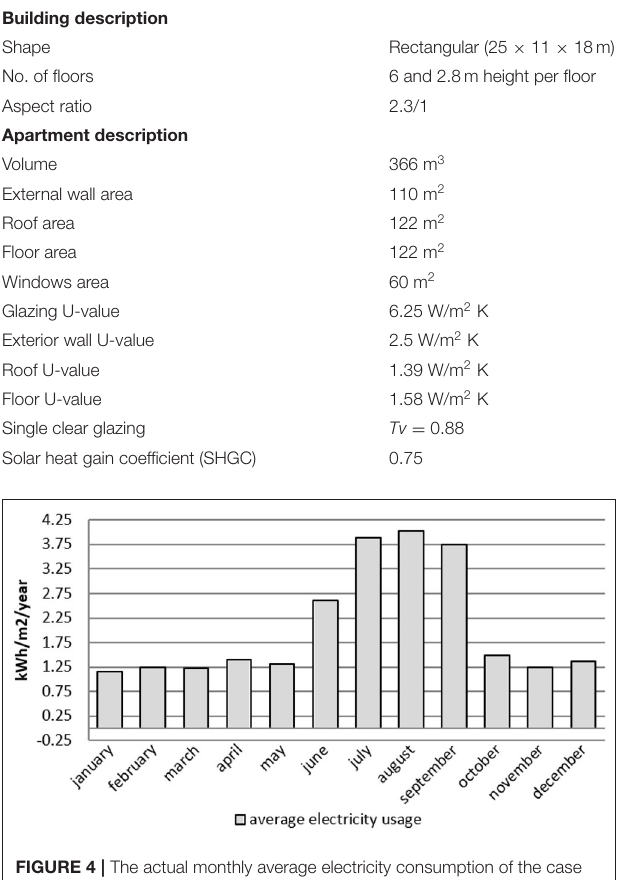
monthly average electricity consumption with a yearly average consumption of 26.6 kWh/m 2 (Attia et al.,